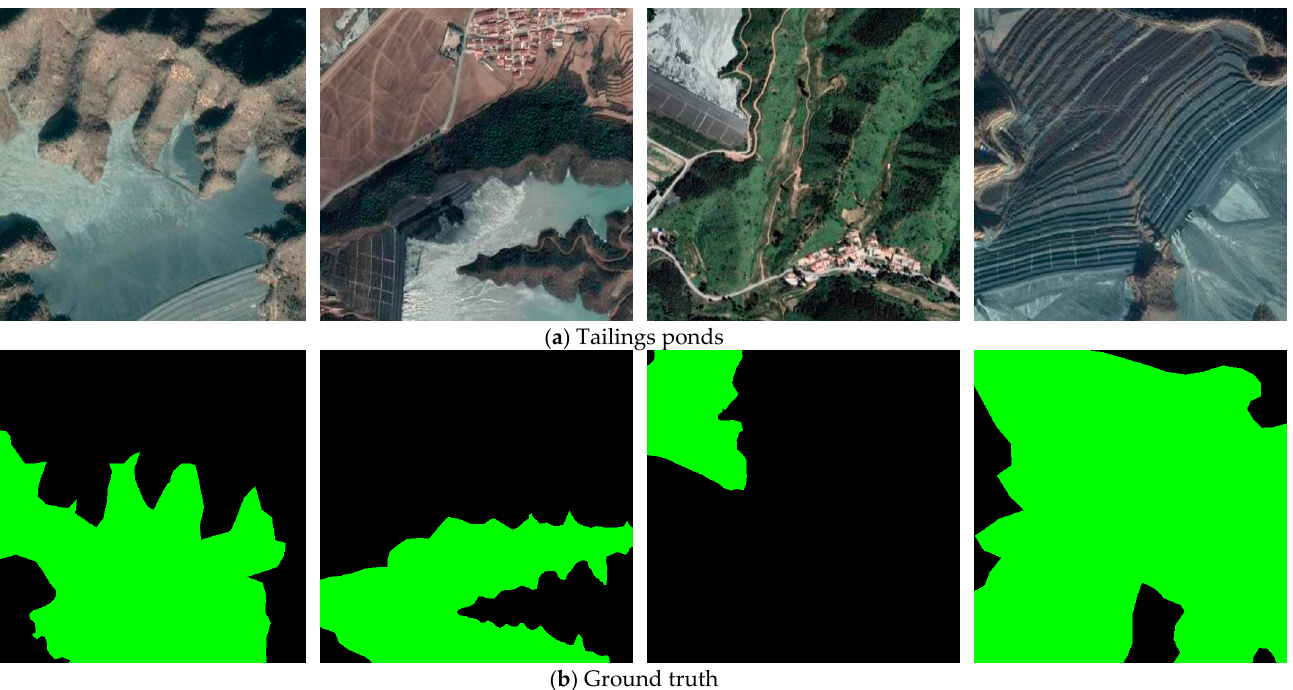
Figure 8. The example of semantic segmentation dataset of tailings ponds. ( a ) Remote sensing images of tailings ponds; ( b ) corresponding ground truth.